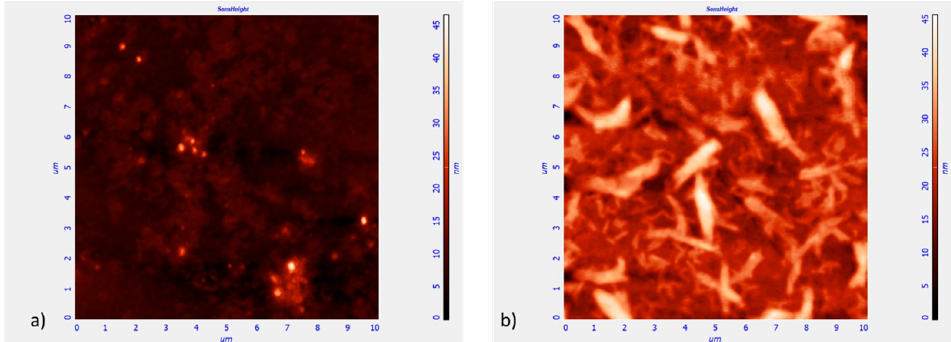
Figure 5 . ( a ) AFM image of the CoCoPo 2 and ( b ) TbPc 2 (OC 11 H 21 ) 8 L-S layers deposited onto MOSPR transducers .